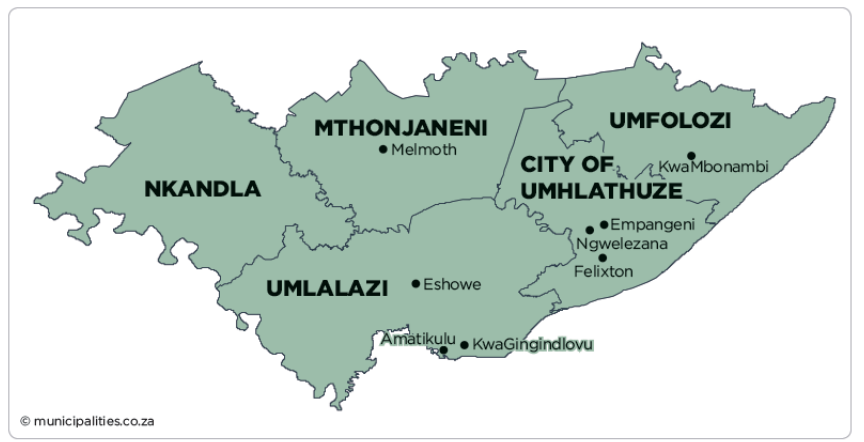
Figure 1. Geographical map representing King Cetshwayo district, KwaZulu-Natal. Source: https://municipalities.co.za/map/124/king-cetshwayo-district-municipality (accessed on 1 November 2020) [19].